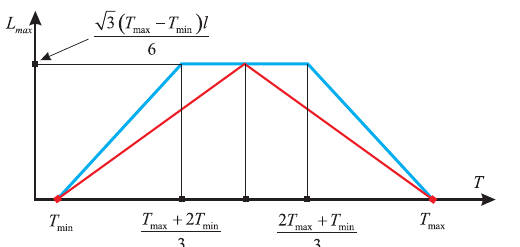
Figure 4: Comparison between the maximum roll torques achiev- able in the weighted pseudo-inverse matrix case L weighted max (blue line) and in the classical case L classical max (red line) vs. thrust T